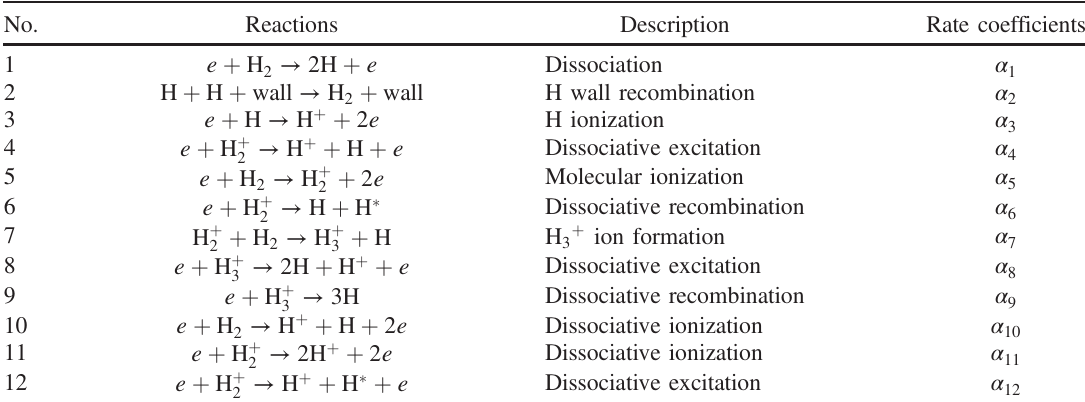
TABLE II. List of the main processes of hydrogen plasma inside the positive ion source. No.